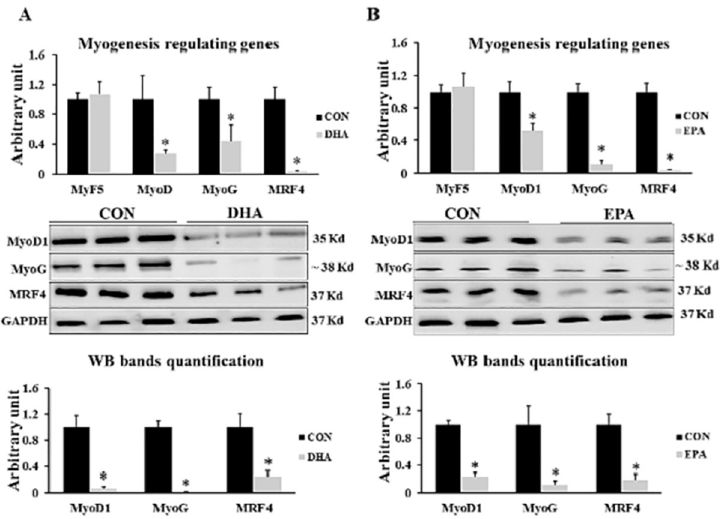
Fig 1. The effect of DHA and EPA on myogenesis regulating genes. C2C12 cells were treated with white adipogenesis induction differentiation medium (WIDM) in the absence (CON) or presence of individual doses of 50 μ M EPA and 50 μ M DHA for 10 days. All the values of RT-qPCR were normalized to the expression levels of 18s genes and calculated in arbitrary units, n = 6. Data are represented as mean ± SEM. The significant differences are presented as � P < 0.05, Student’s t test. The level of GAPDH was used as a housekeeping gene to normalize the Western blots data. (A) Effect of DHA on the expression of myogenesis regulating genes. (B) Effect of EPA on the expression of myogenesis regulating